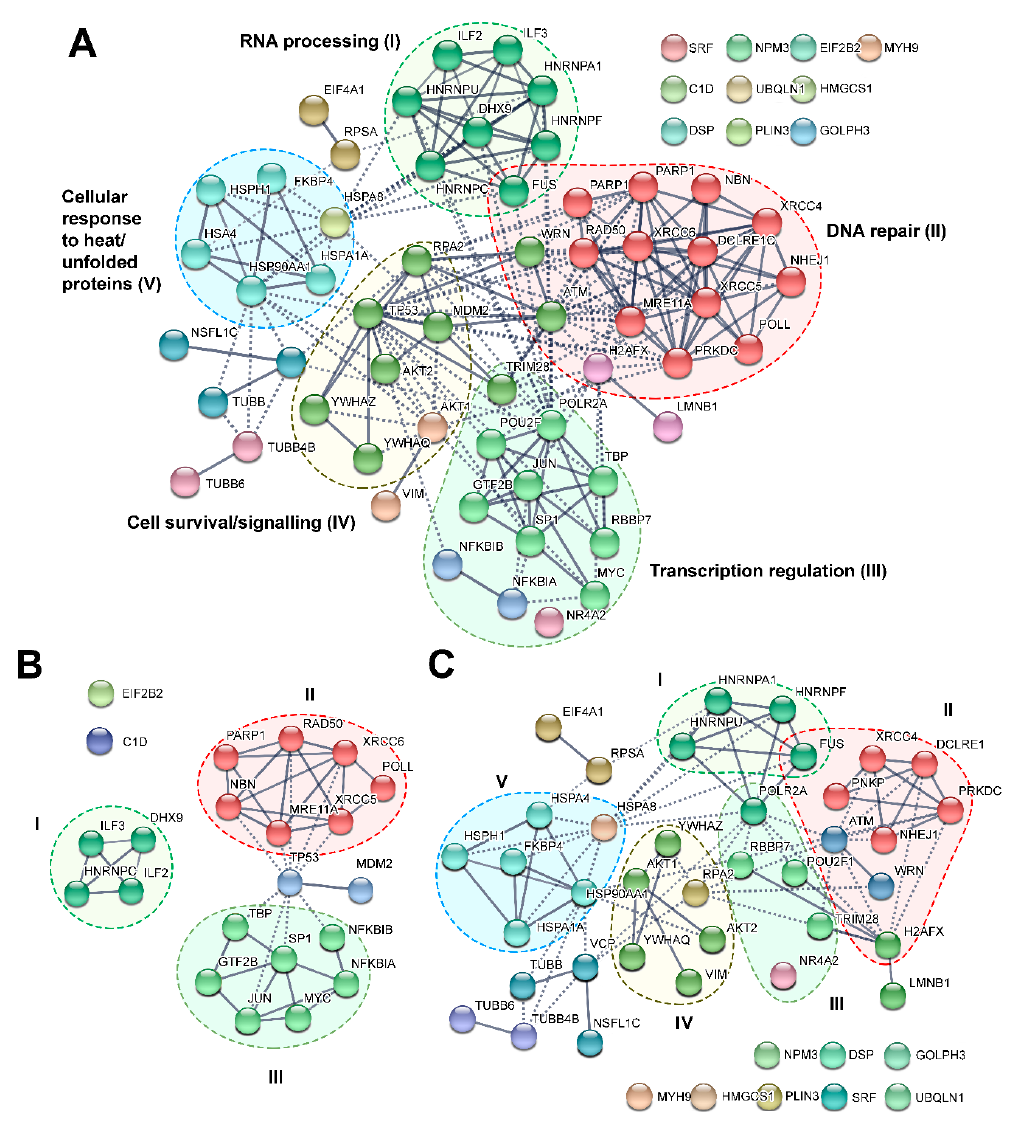
Figure 2. Protein–protein interactions network of DNA-PKcs targets described in Table 1 ( A ). PPI networks of DNA-PKcs targets identified only in in vitro experiments ( B ) and in in vivo or both in vitro and in vivo experiments ( C ). The most connected nodes are the same color and are grouped in a cluster using Markov Cluster Algorithm (MCL) with inflation parameter 3.1.